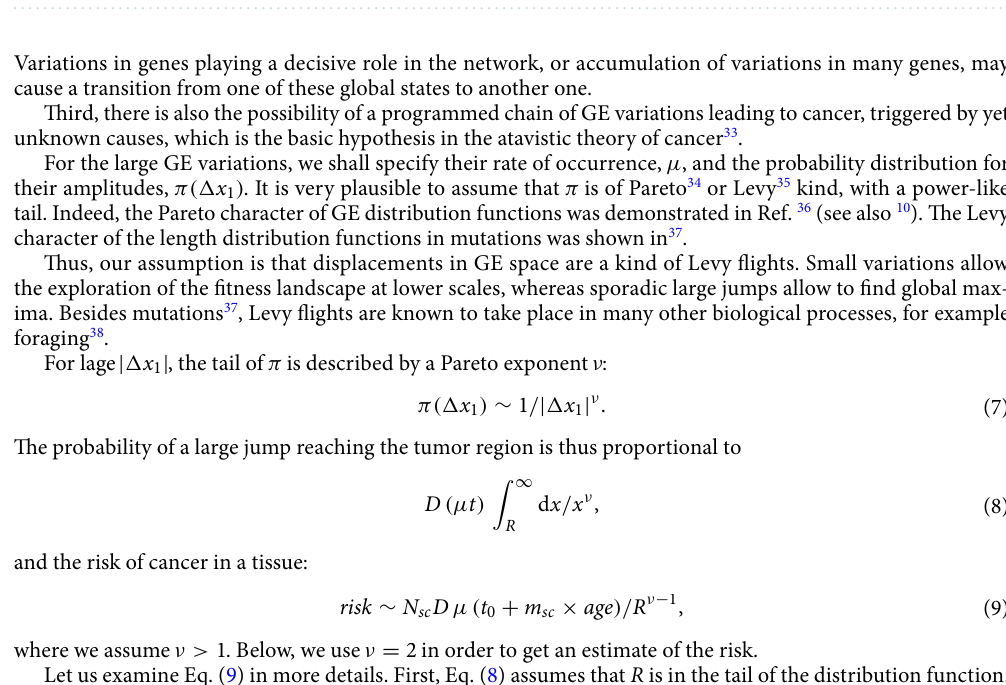
Figure 4. Testing the ability of Eq. (10) to describe the cancer risk in 8 tissues. The error bars were estimated by means of the last column of Table 2. The slope of the linear fit is near one, as expected. 72 % of the data dispersion is explained by the linear dependence (p-value =